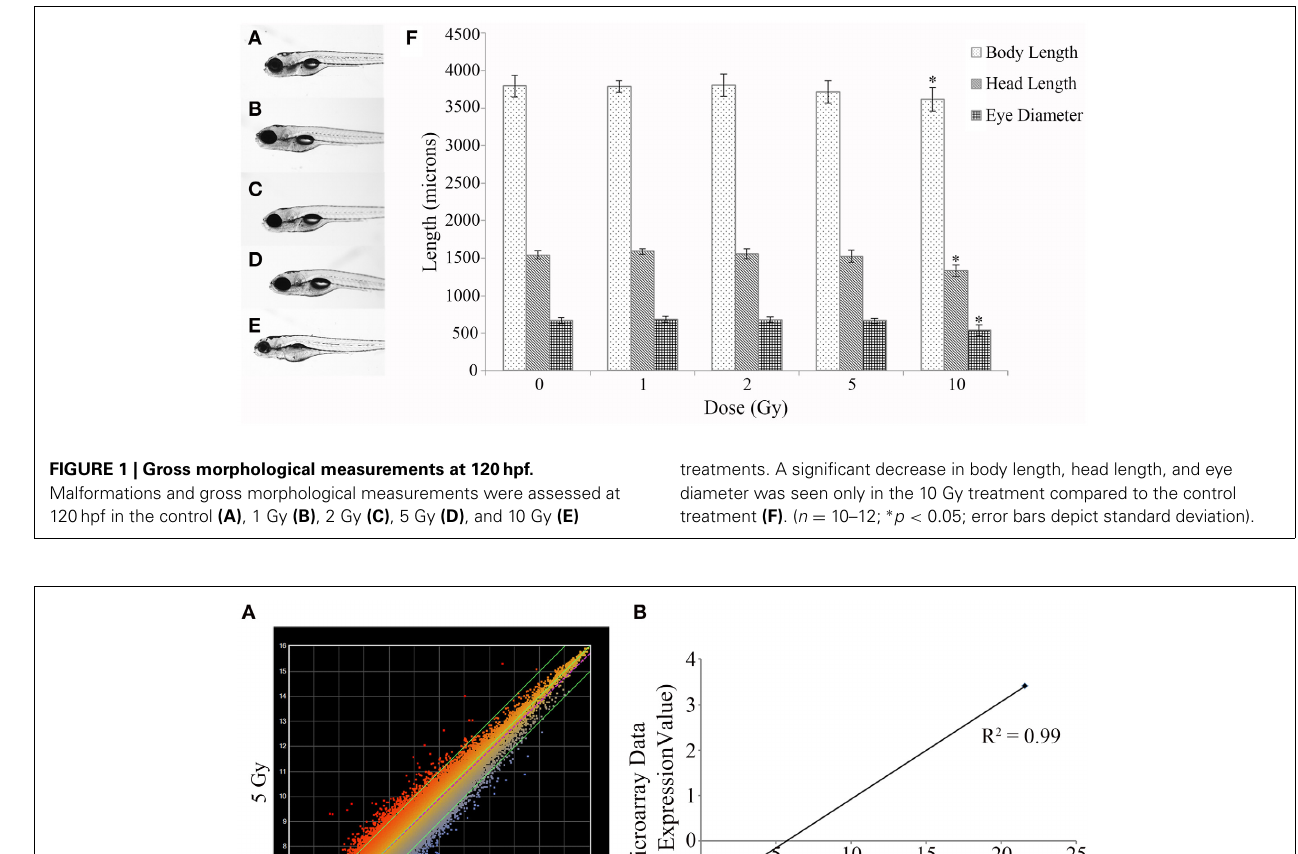
FIGURE 2 | Transcriptomic and qPCR comparative analysis at 5 Gy. Mean intensity values for each probe are plotted with IR dosed larvae (y-axis) against control treatment (x-axis) (A) . Using set criteria 609 probes were altered at the 5 Gy dose. qPCR analysis was performed to compare gene expression changes detected on the microarray on six gene targets. A linear correlation was completed and statistical